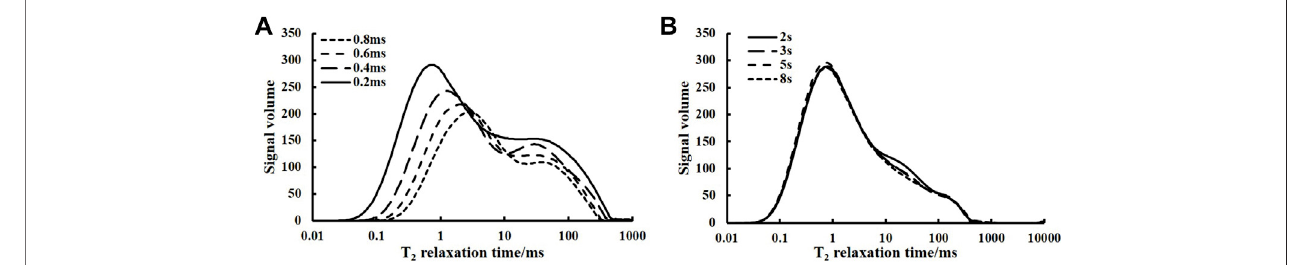
FIGURE 3 | T 2 spectra at different T E and T W values. (A) T 2 spectra in fl uenced by T E and (B) T 2 spectra in fl uenced by T W